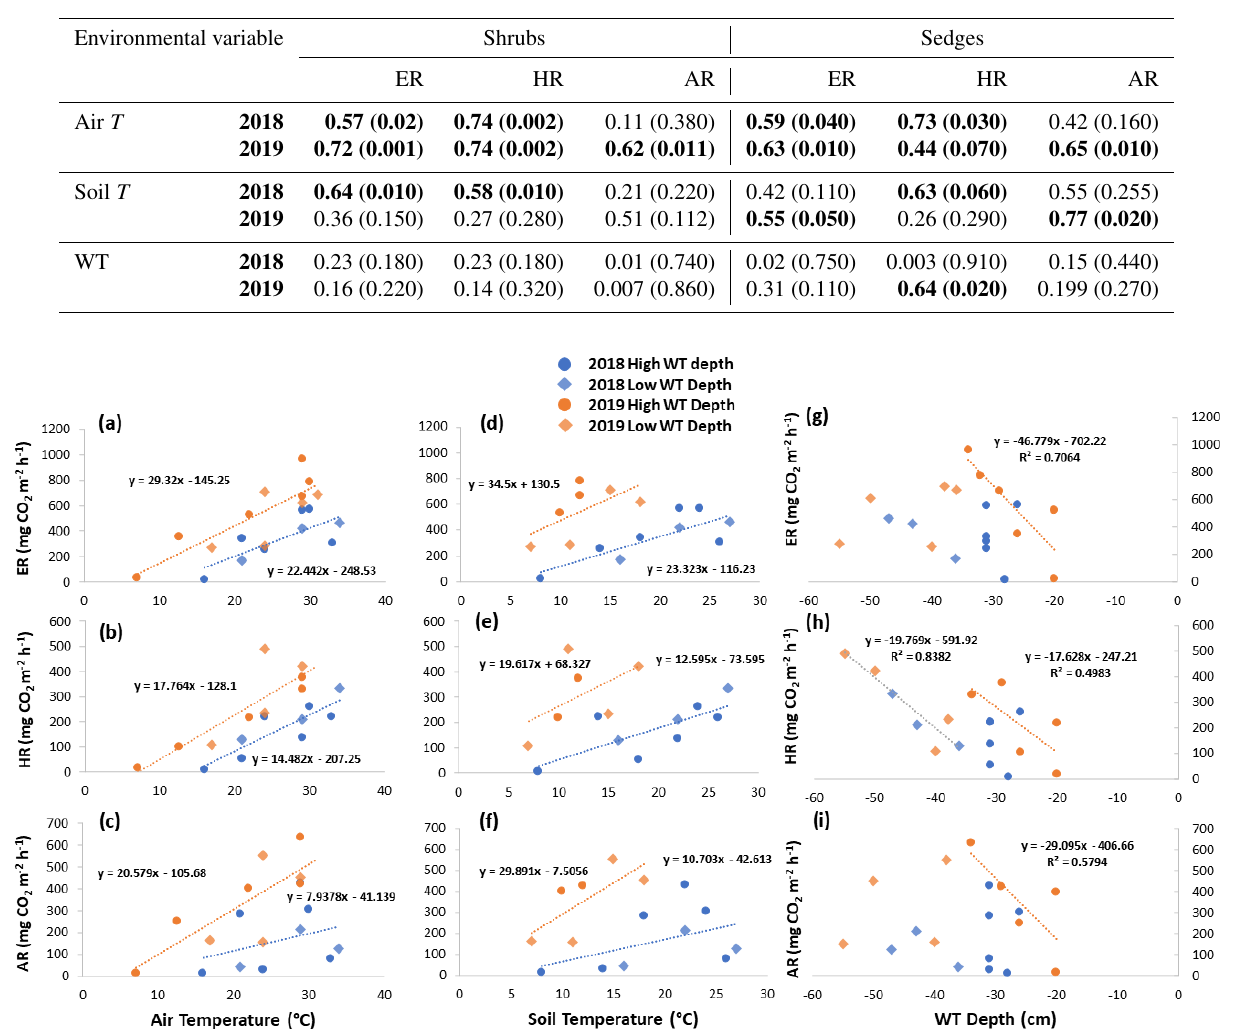
Table 3. Coefficient of determination ( R 2 ) for linear regressions between respiration (ER, AR, and HR) and environmental variables in 2018 and 2019 with p values in brackets and significant relationships ( p< 0 . 1) in bold. WT is water table depth, air T is air temperature measured at the flux tower, and soil T is soil temperature at 10cm depth.